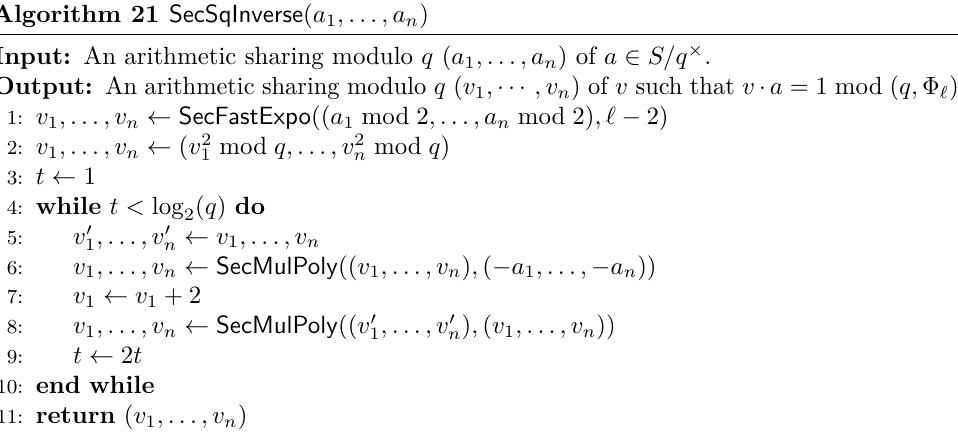
Algorithm 21 SecSqInverse ( a 1 , . . . , a n